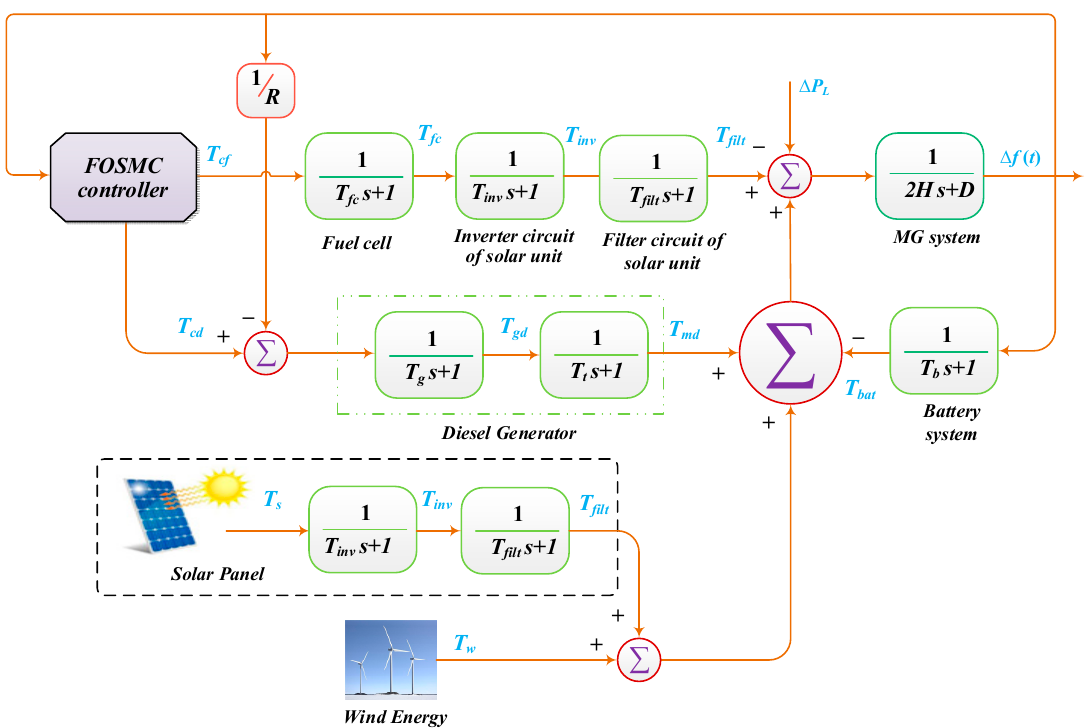
Figure 3. The overall microgrid (MG) scheme for load frequency control (LFC). FOSMC: fractional order sliding mode control.